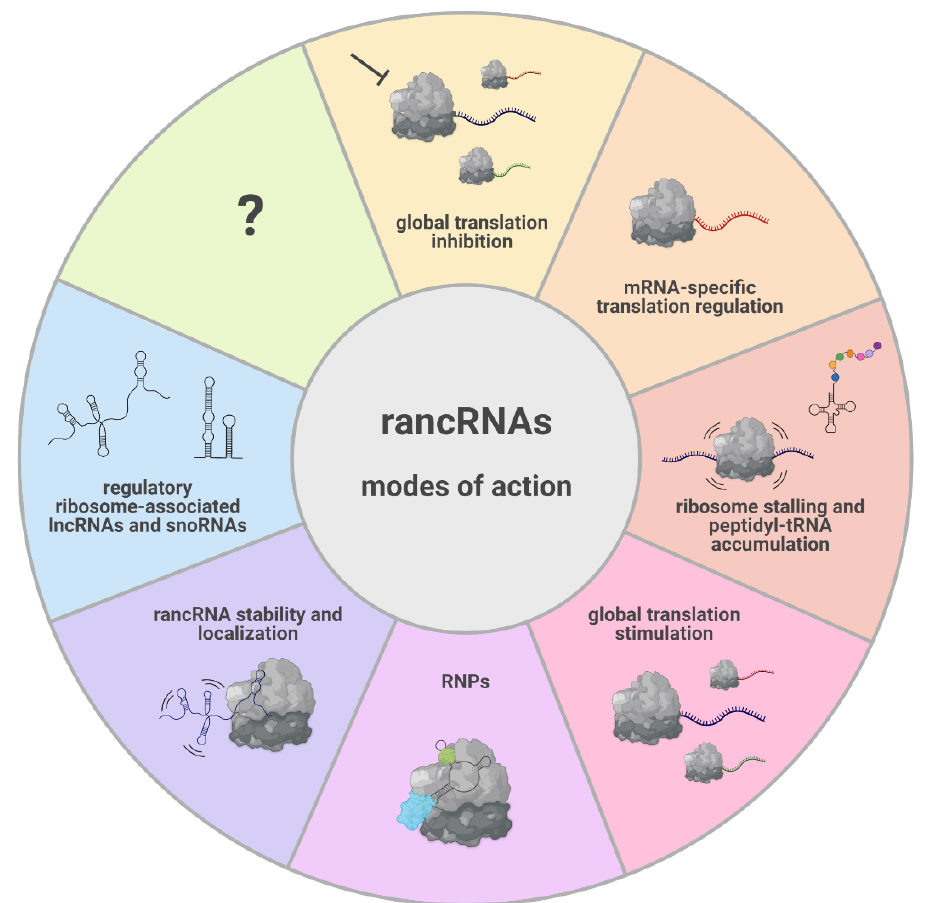
Figure 3. The diverse modes of action of rancRNAs and the functional consequences of their interaction with the ribosome. RancRNAs can exert their biological role as naked RNA molecules or as part of RNP complexes (e.g., SRP). The binding of rancRNAs to the ribosome can influence their stability. The origin and length of rancRNAs is extremely diverse, spanning from lncRNAs to very small RNA fragments. The interaction with the ribosome can modulate translation on a global level; the interaction is able to inhibit (e.g., yeast rancRNA_18) and stimulate (e.g., Trypanosomal tRNA Thr 3 (cid:48) half) translation, target the expression of specific mRNAs (e.g., archaeal rancRNA_s194), or cause ribosome stalling and peptidyl-tRNA accumulation (mammalian tRNA Pro 5 (cid:48)